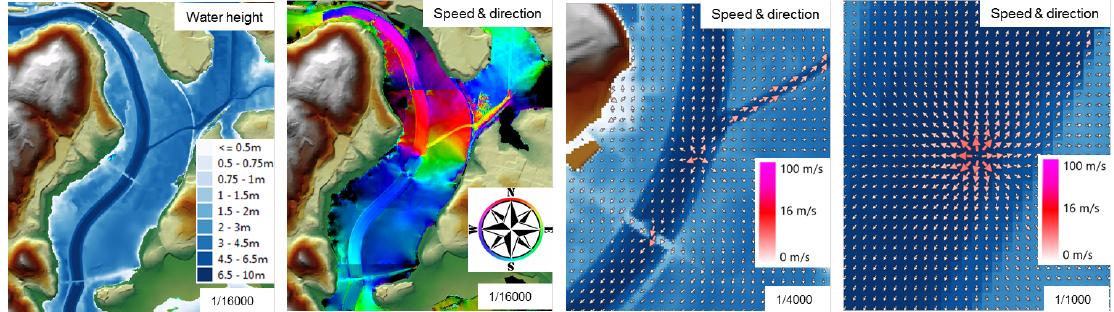
Figure 5. Multiscale styles for hydraulic data visualization: 1- Water heights with a proper colormap (classical blue style), 2- Merged flow directions and velocities: with a color wheel (a), with a first level of zoom based on arrows (b), with a second level of zoom based on arrows (c) (automated multi-scale style).